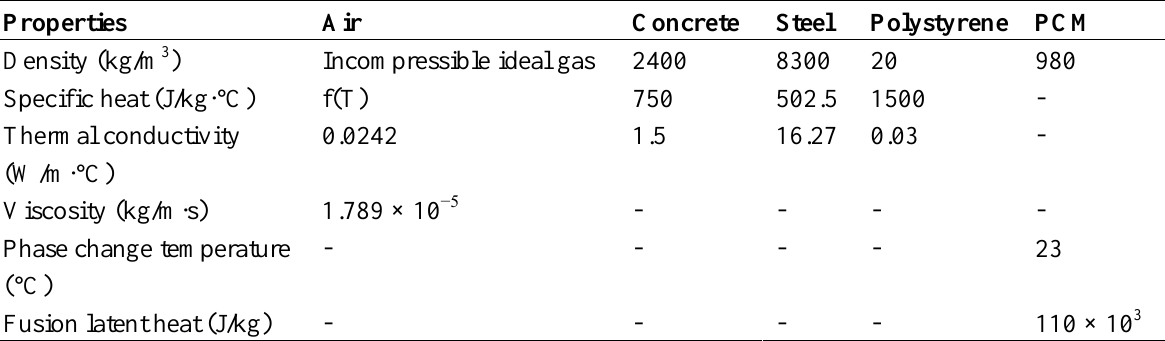
Table 3. Characteristics of the materials used in the simulation.